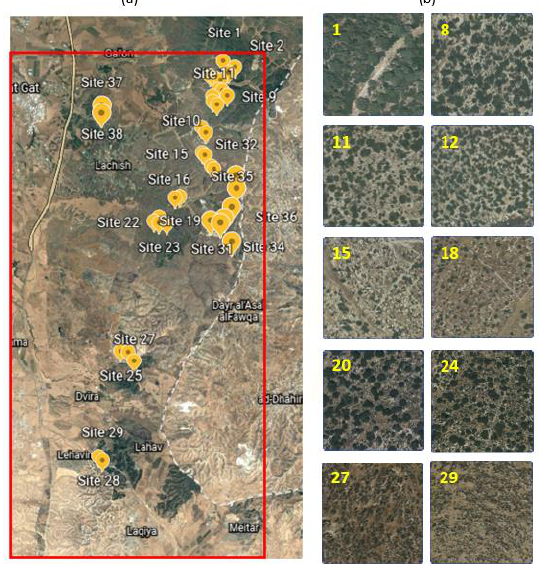
Figure 1: (a) Study area (adopted from Google Earth). (b) Examples of the research sites (adopted from https://www.govmap.gov.il/)